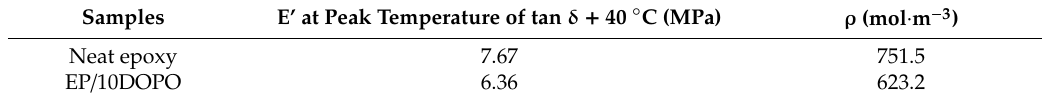
Table 1. Storage modulus (E’) in rubbery region and crosslinking density of neat epoxy resin and EP / 10DOPO.